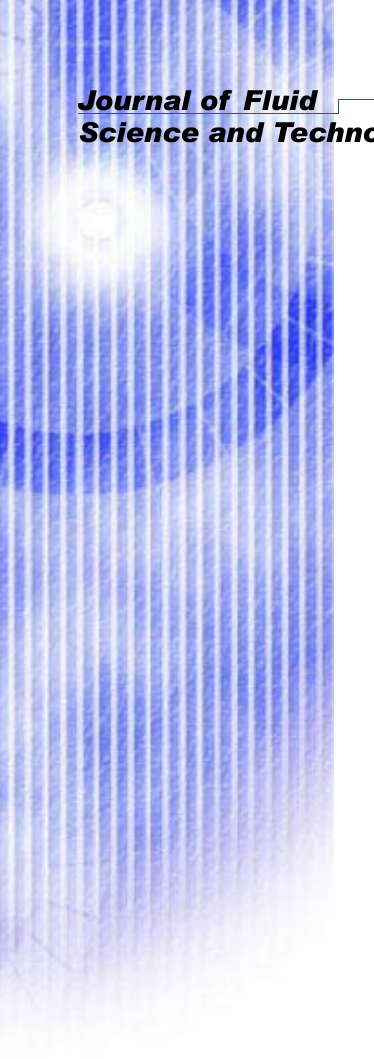
Figure 1 - Experimental setu